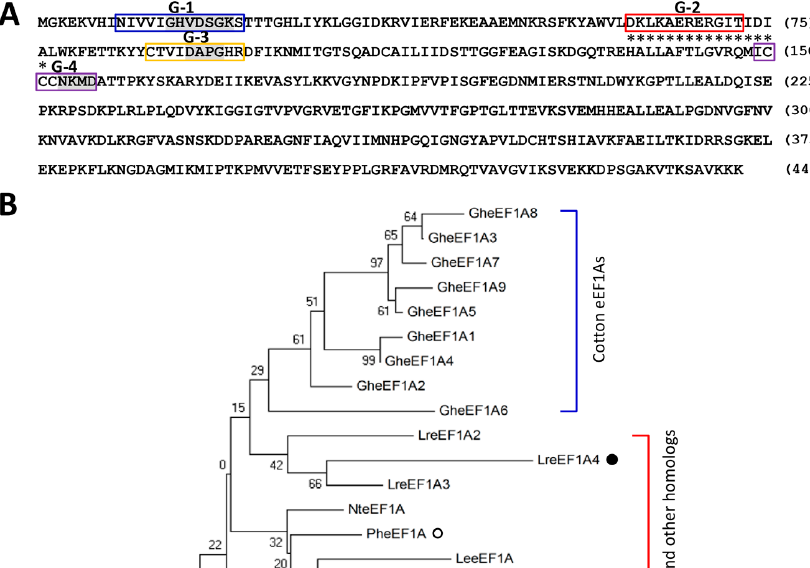
ZmeEF1A5 (AAF42980), ZmeEF1A6 (AAF42981), and ZmeEF1A7 (AAF42982). LreEF1A4 and PheEF1A are highlighted by solid and hollow circles. Boot-strap values were determined as a percentage of 1000 replicates and shown at corresponding branch nodes. Scale bar denotes the number of amino acid substitutions per